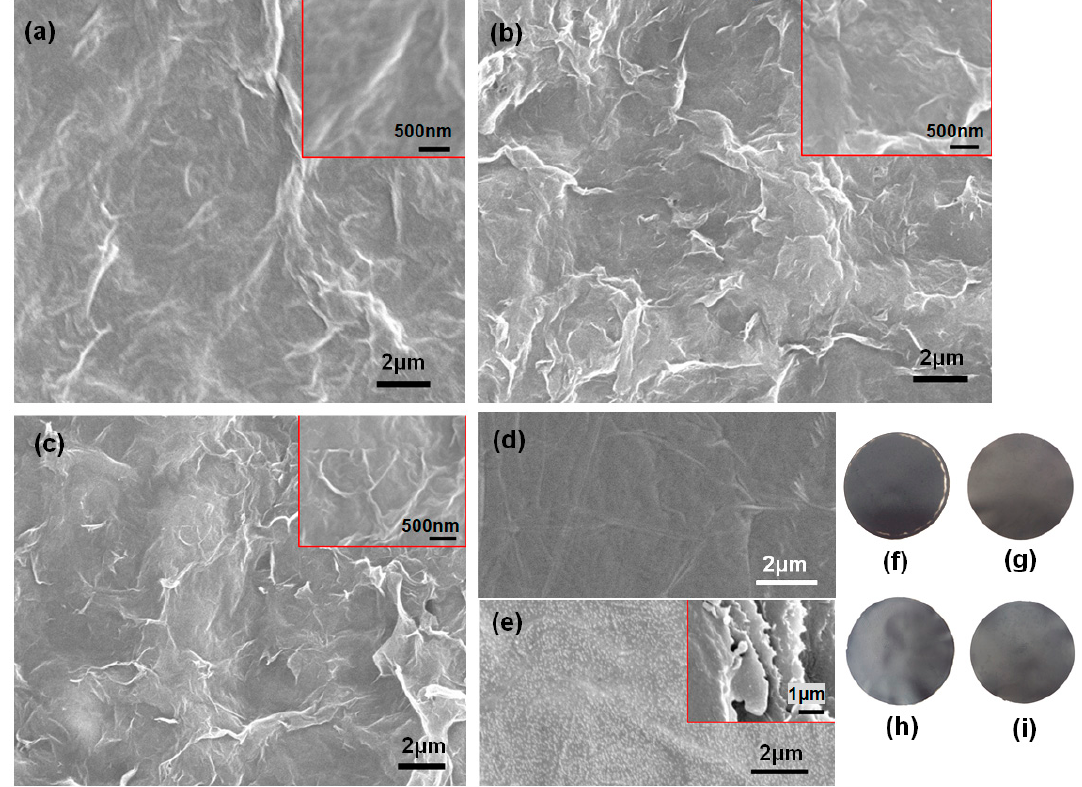
Figure 4. Scanning electron microscope (SEM) images of the surface morphology of composite membranes with ( a ) 20 wt.% graphene, GO:NFC = 1:1; ( b ) 50 wt.% graphene, GO:NFC = 1:9; ( c ) 50 wt.% graphene, GO:NFC = 1:1; ( d ) Pure GO membrane (16 g·m − 2 ) formed by vacuum filtration; and ( e ) pure NFC membrane (16 g·m − 2 ), also by vacuum filtration. A cross-section of the NFC membrane is inset in ( e ). Photographs of the membranes after drying: ( f ) 1 g·m − 2 and ( g ) 8 g·m − 2 grammage; ( h ) 30 and ( i ) 50 wt.% graphene.